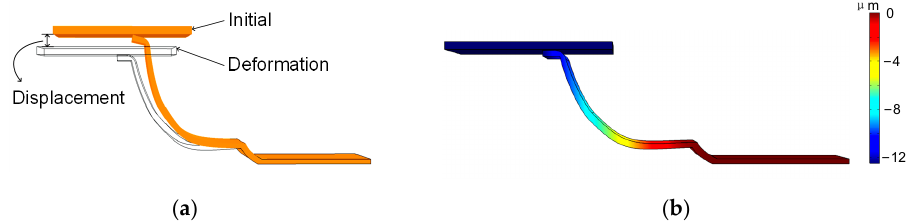
Figure 5. Schematic views of the ( a ) deformed CMI and ( b ) vertical displacement distribution.